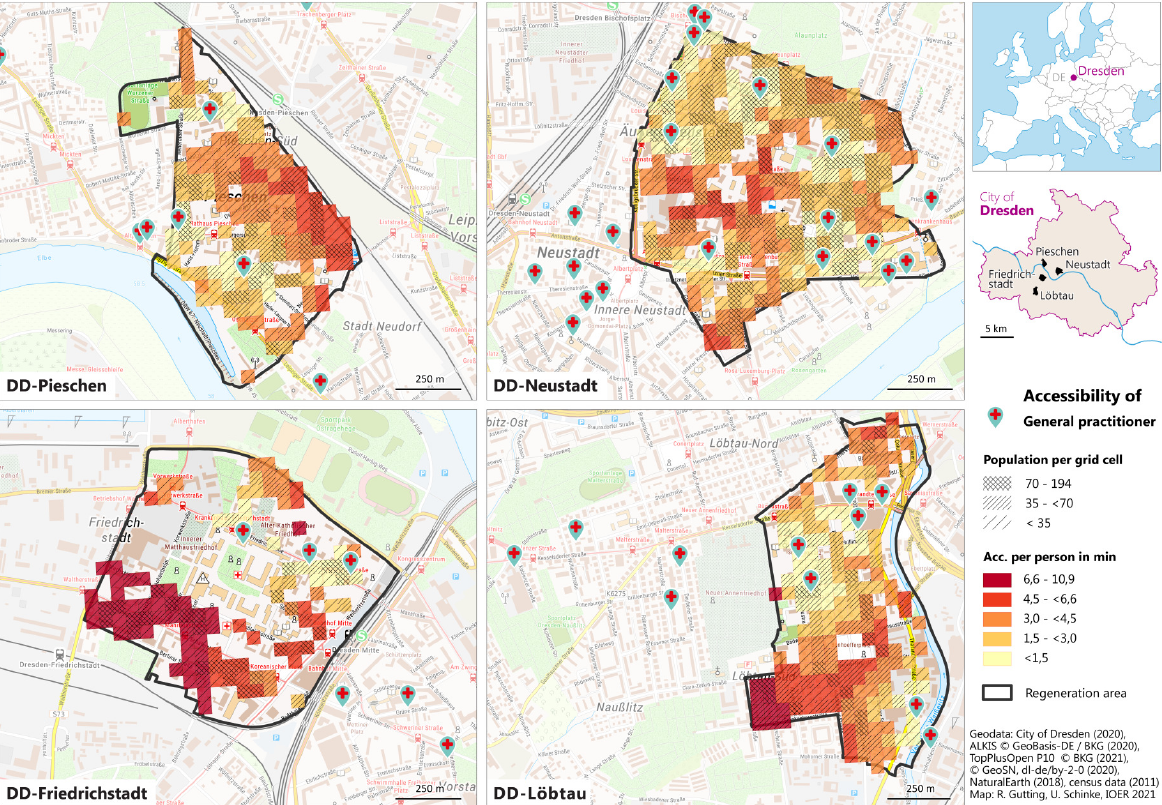
Figure 4. Grid cells showing population density and walking distance in minutes to nearest general